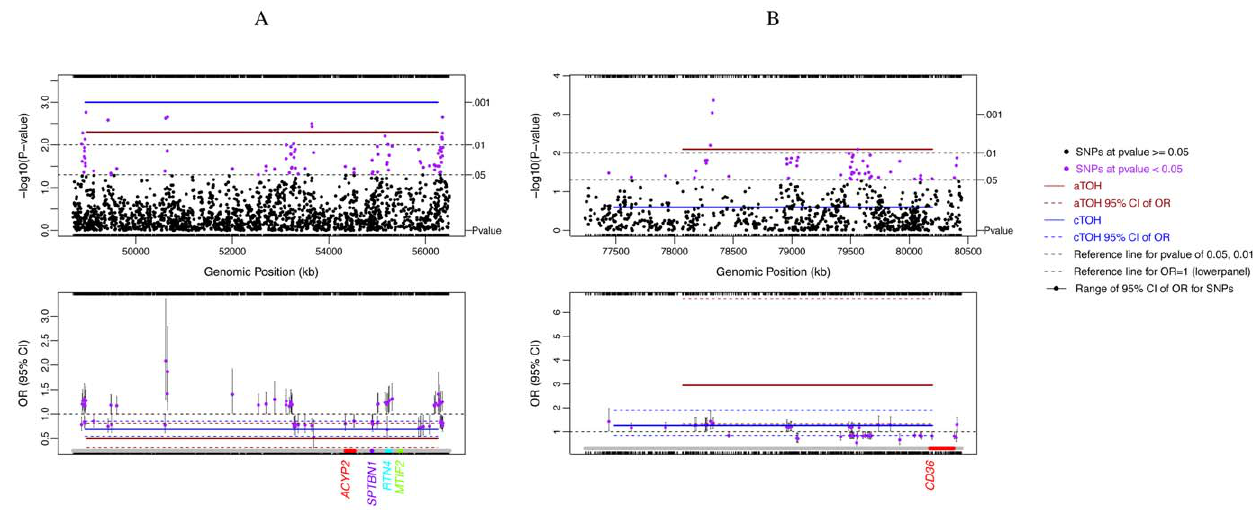
Figure 2. cTOH3/aTOH1 and aTOH4 regions under-represented in lung cancer cases compared to controls. Single-SNP association analysis was performed independently of TOH analysis and compared. The significant associations of single SNPs, and each TOH with lung cancer cases versus controls, and their respective 95% CI (colored dashed lines), are shown. Below each of the lower panels are candidate gene names (multi- colored) which were prioritized after testing for association between lung cancers and differential expression of each of the genes within and + / 2 250 kb of the TOH, stratified by smoking status (p , 0.0001; see Methods section). A. cTOH3/aTOH1 region (2 p16.3–16.1; brown line) significantly under-represented in lung cancer cases and GWAS-identified SNPs (purple dots) in the same region (top panel) with their respective corresponding risks as odds ratios (lower panel). B. aTOH4 (7q21.11; brown line) significantly under-represented in lung cancer cases and GWAS-identified SNPs (purple dots) in the region (top panel) with their corresponding lung-cancer risks as odds ratios (OR; lower panel).